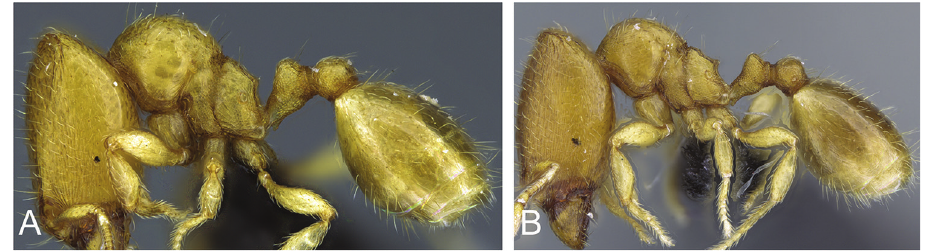
Figure 17. Mesosoma, petiole and postpetiole in profile view of A Carebara sampi (CASENT0030374) B Carebara lova (CASENT0470762).